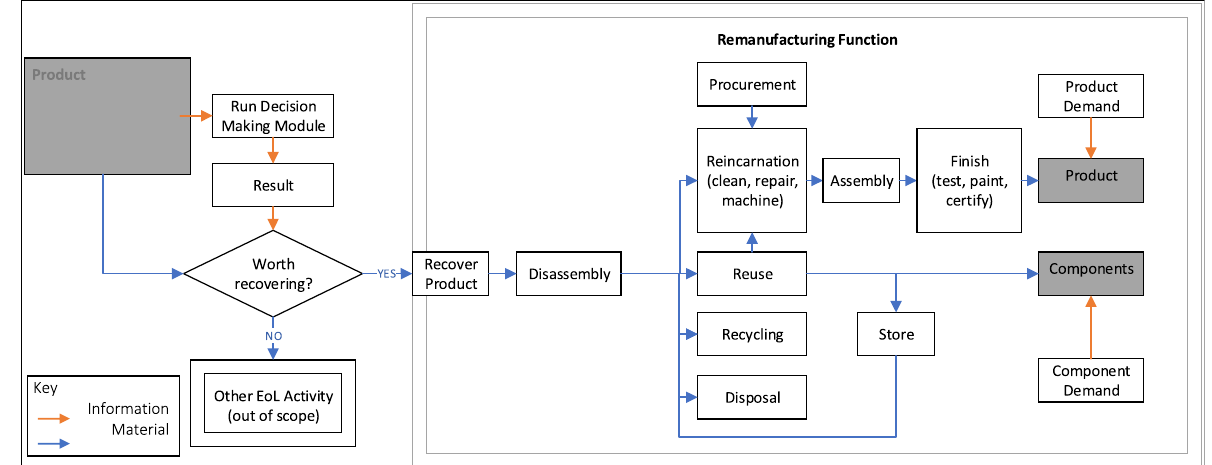
Figure 2. Relationships between DMM and the remanufacturing